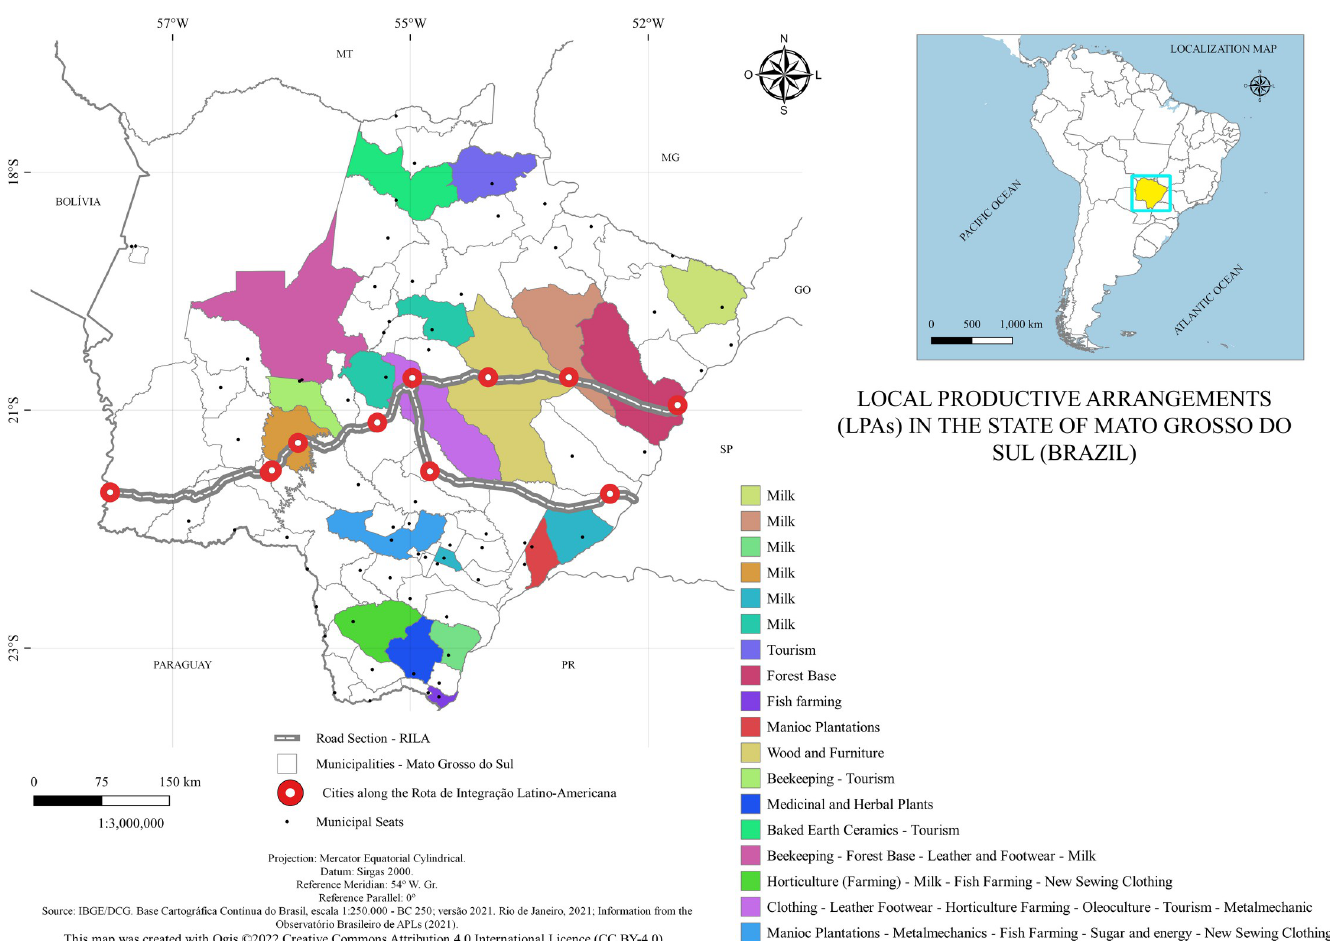
Fig 5. Local Productive Arrangements (LPAs) in the State of Mato Grosso do Sul (Brazil). Caption credit: Elaborated based on information from the [17].